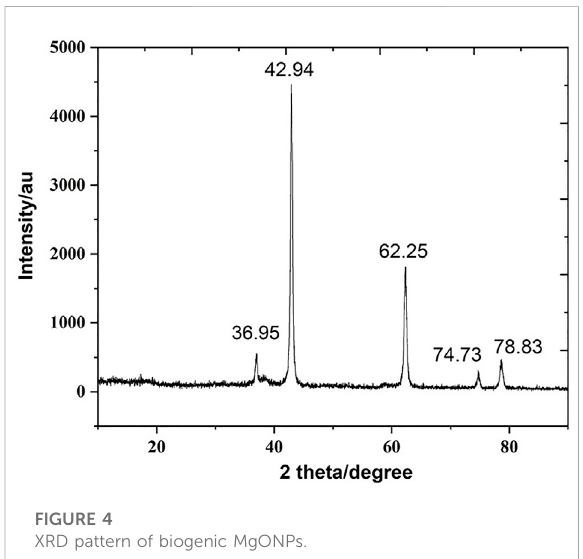
FIGURE 4 XRD pattern of biogenic